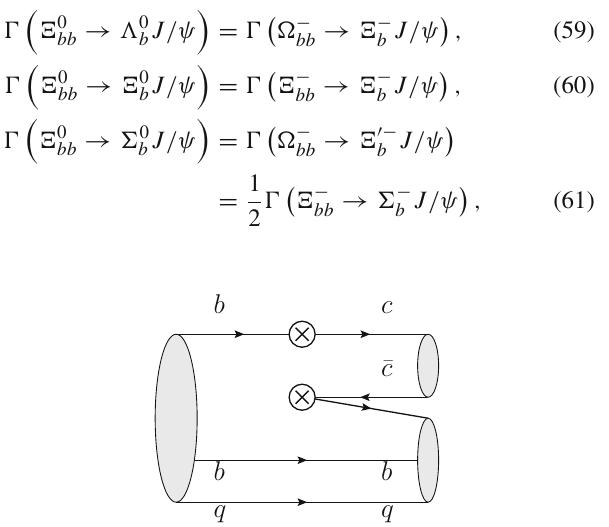
Fig. 6 The Feynman diagrams for (cid:2) bb and (cid:5) bb decays into J /ψ and